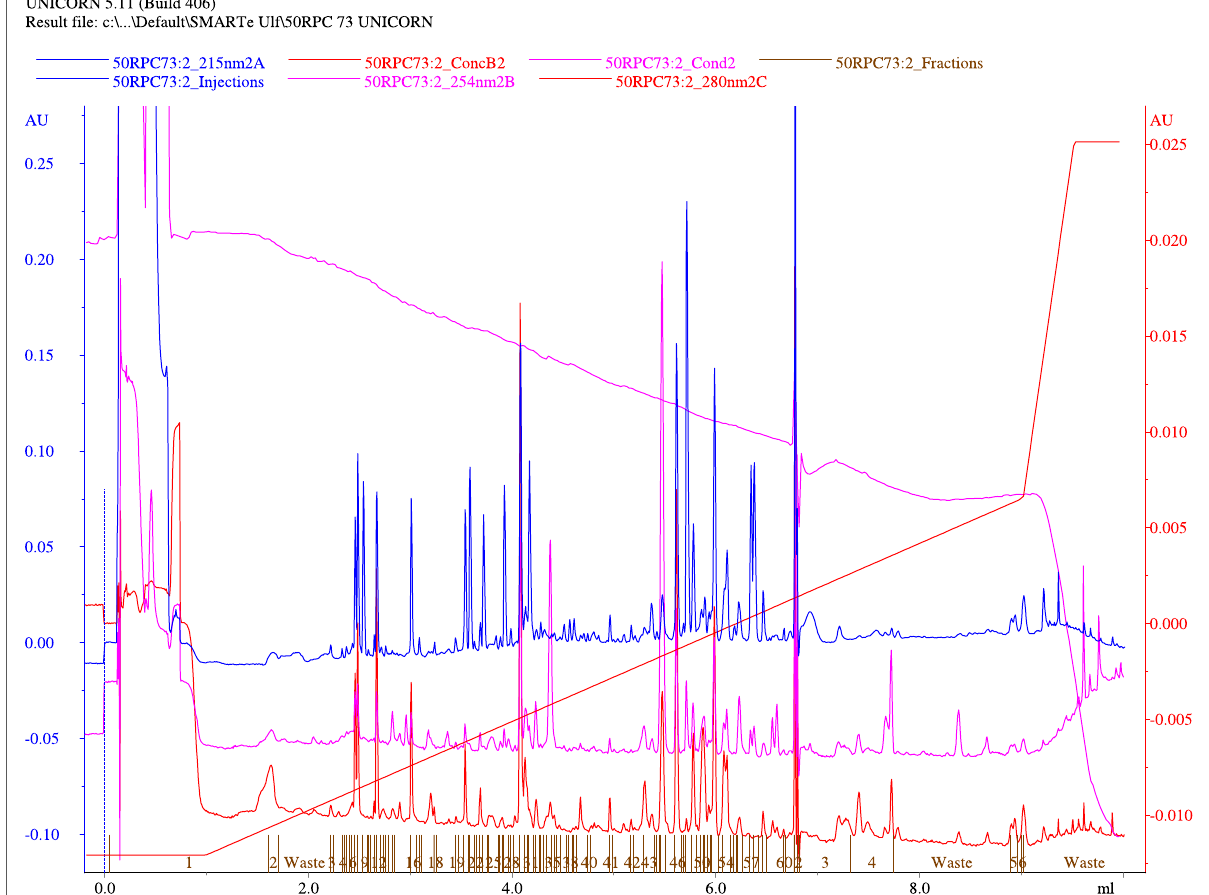
Fig. 4 Reverse‑phase high‑performance liquid chromatography of lysine‑C digest of BaGST2. A total of 40 μg of pure sample was reduced with 10 mM DTT at 95 °C, then alkylated in the dark with 20 mM iodoacetamide, and then subjected to SDS‑PAGE. After staining and destaining, bands were excised and treated for in situ digestion with lysine‑C‑specific